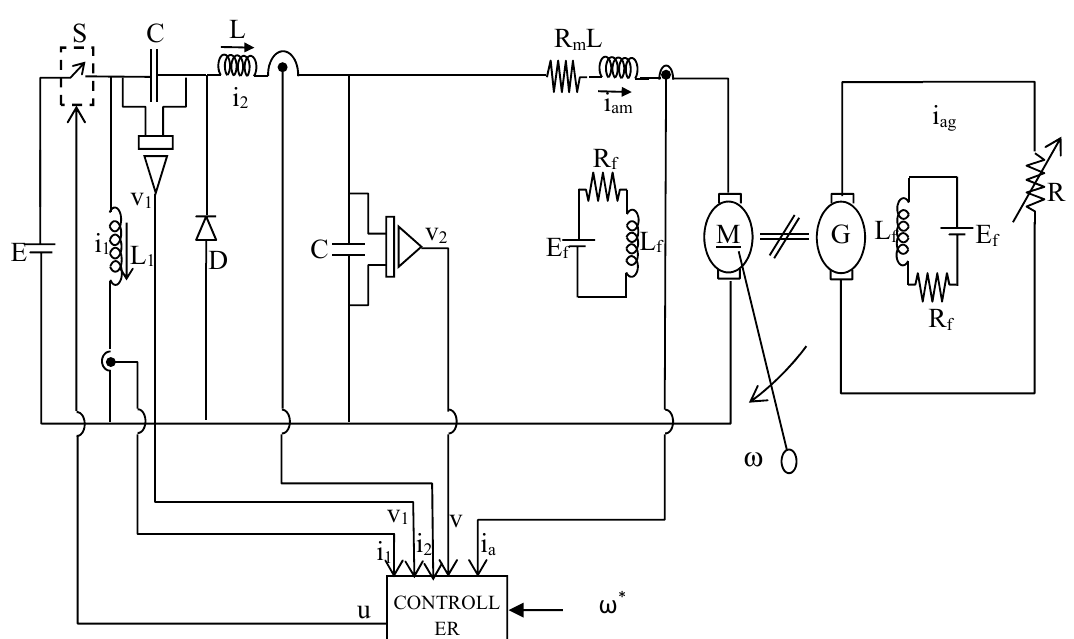
Figure 1. Non-flat Luo converter with dynamic load for low-cost passivity-based control (PBC) implementation.